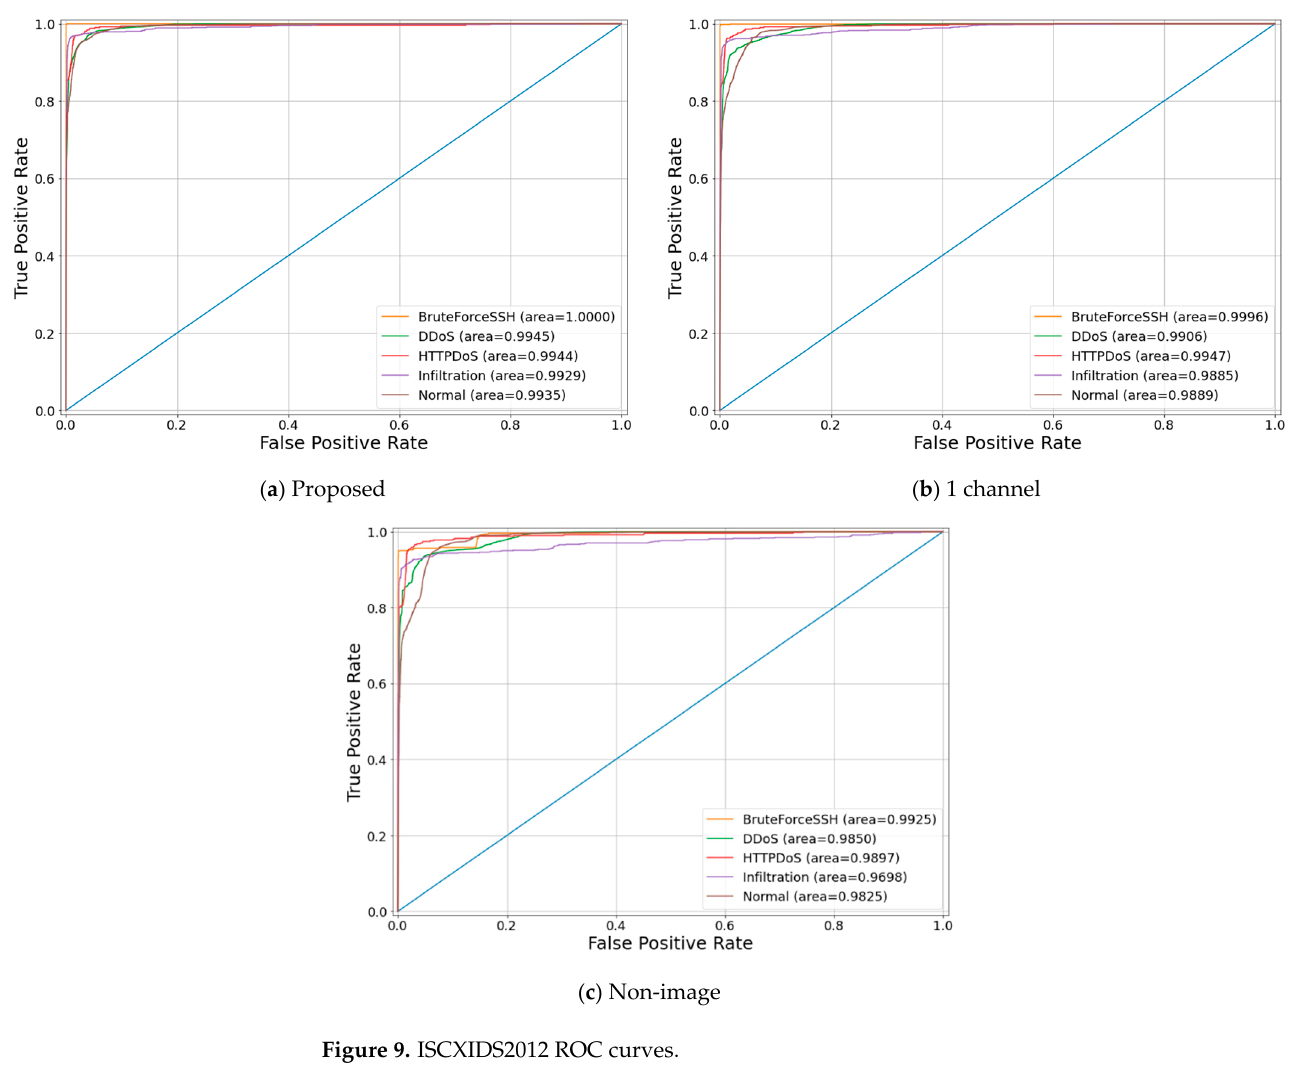
Figure 9. ISCXIDS2012 ROC curves.